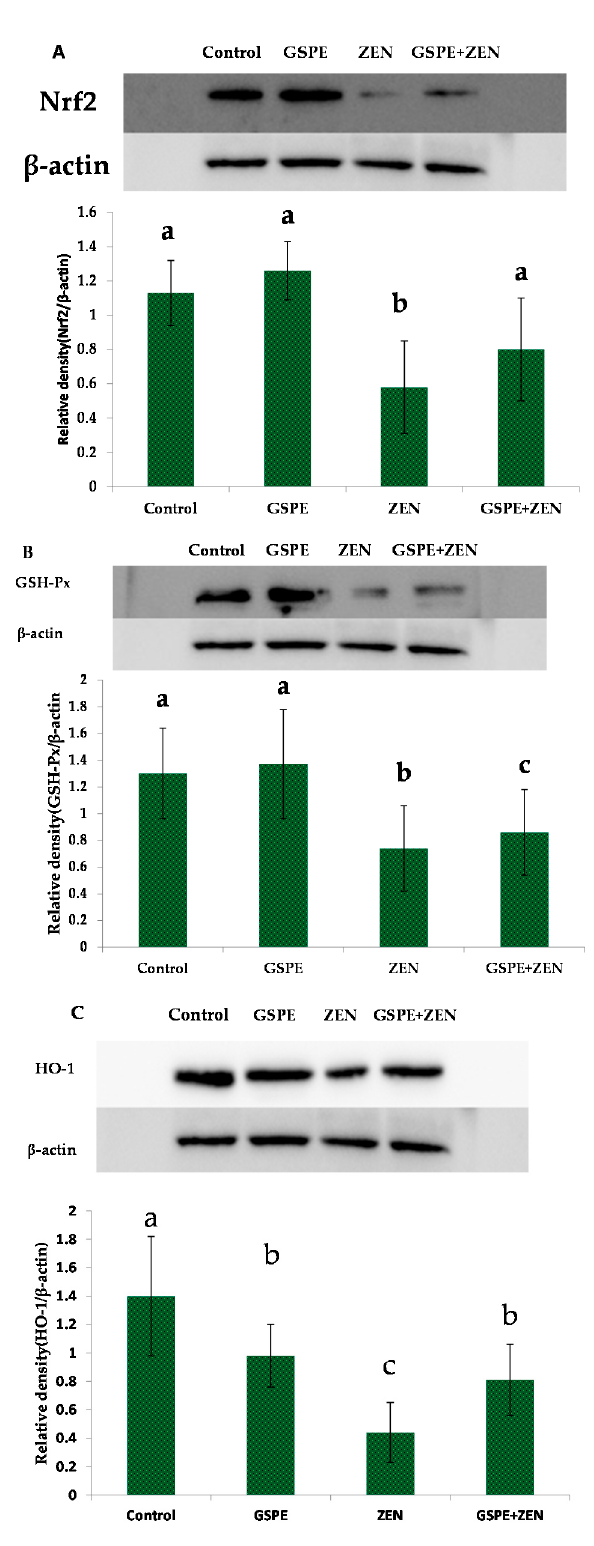
Figure 3. Cont. Figure 3.